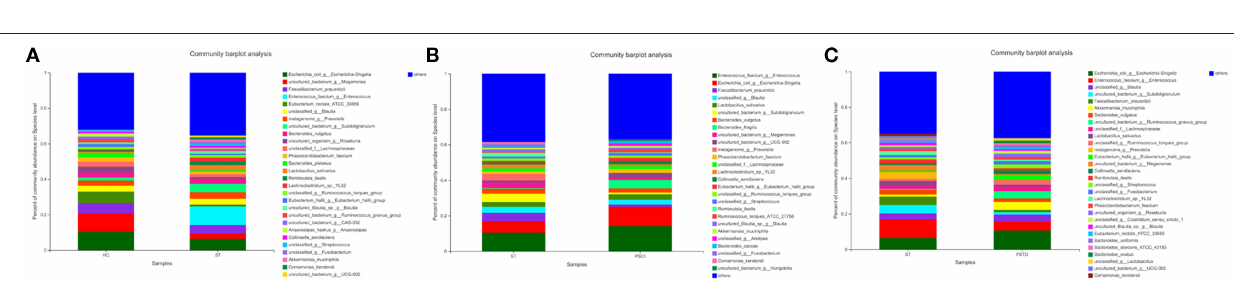
FIGURE 6 | Distribution of the predominant bacteria at genus level in Circos. (A) ST vs. HC, (B) PSCI vs. ST, (C) PSTD vs. ST.